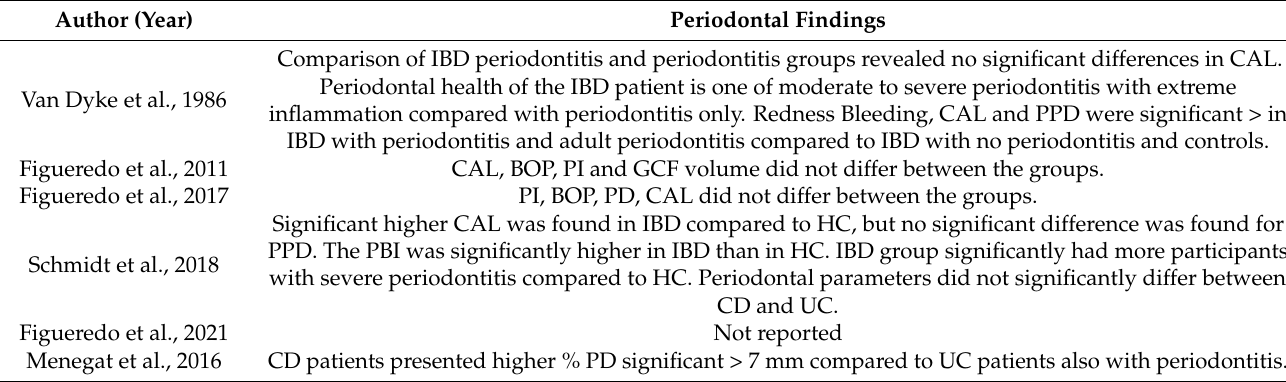
Table 2. Periodontal characteristics of the included studies. Periodontal Findings